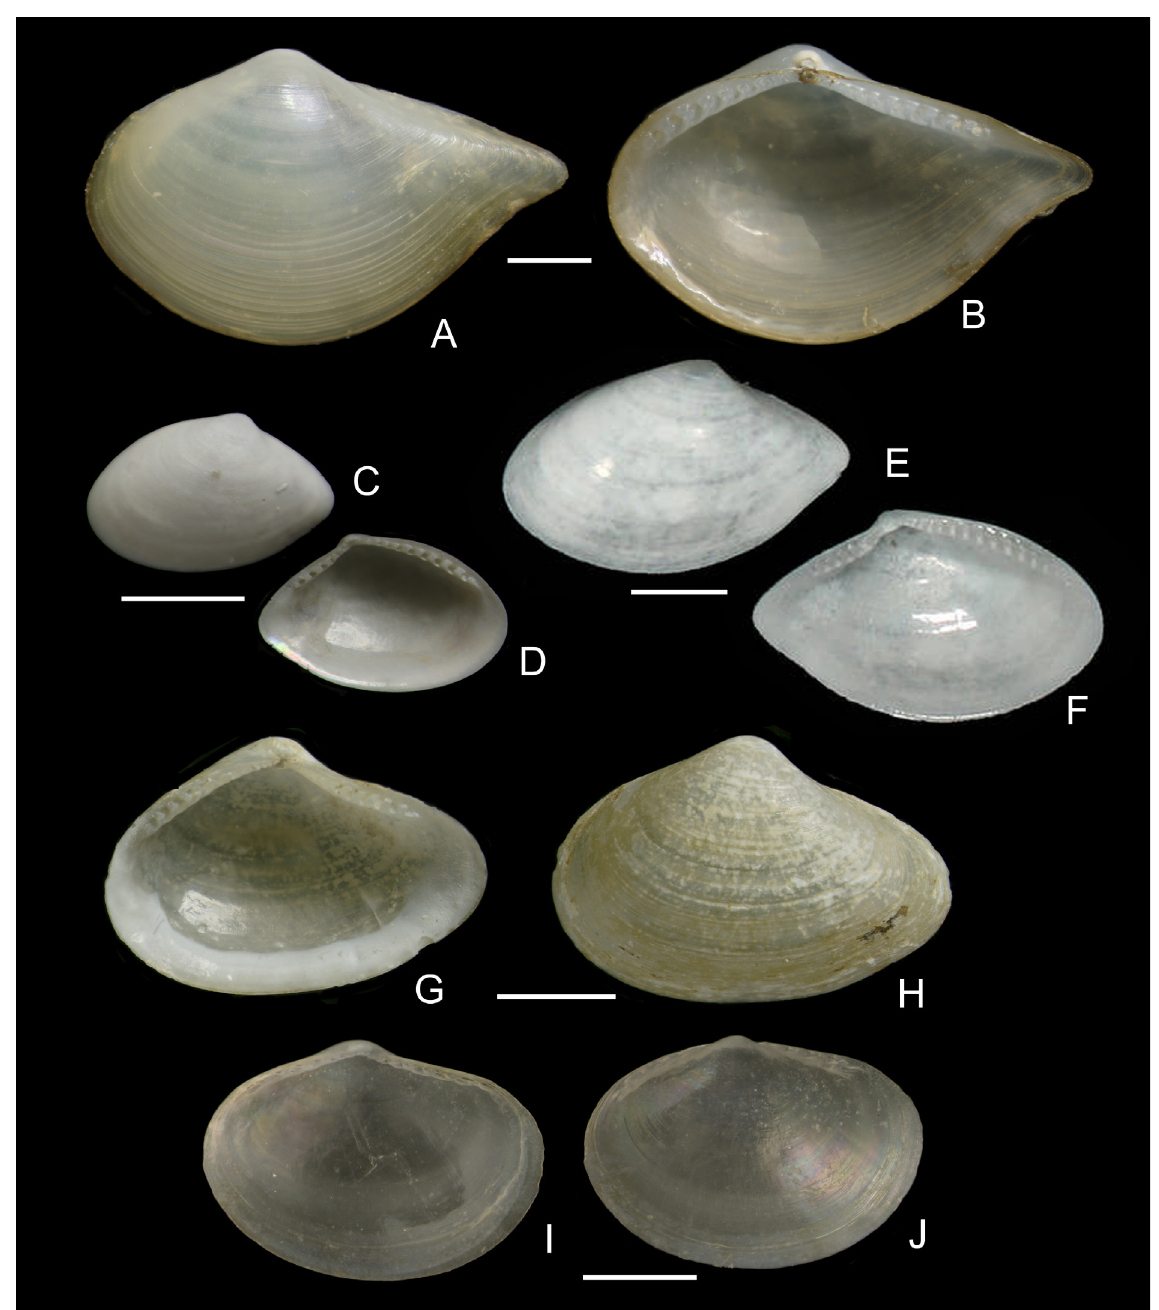
Fig. 32. Protobranchia 2. A–B . Ledella messanensis (Jeffreys, 1870), BANGAL 0711, V10, 1720 m, 5.8 mm. C–D . Ledella cf. orixa (Dall, 1927), BANGAL 0711, V5, 1631 m, 2.0 mm. E–F . Syntype (USNM 108190) of Leda orixa Dall, 1927, off Georgia 30.975°N, 79.6417°W, 538 m, R/V Albatross , 3.6 mm (photograph by Ellen Strong, reproduced with the permission of the National Museum of Natural History, Smithsonian Institution, 10 th and Constitution Ave. N.W., Washington, DC 20560-0193 http://www.nmnh.si.edu/). G–H . Yoldiella semistriata (Jeffreys, 1879), BANGAL 0711, V2, 1706 m, 3.2 mm. I–J . Yoldiella valorousae Killeen & J.A. Turner, 2009, BANGAL 0711, V2, 1706 m, 3.0 mm. Scale bars = 1